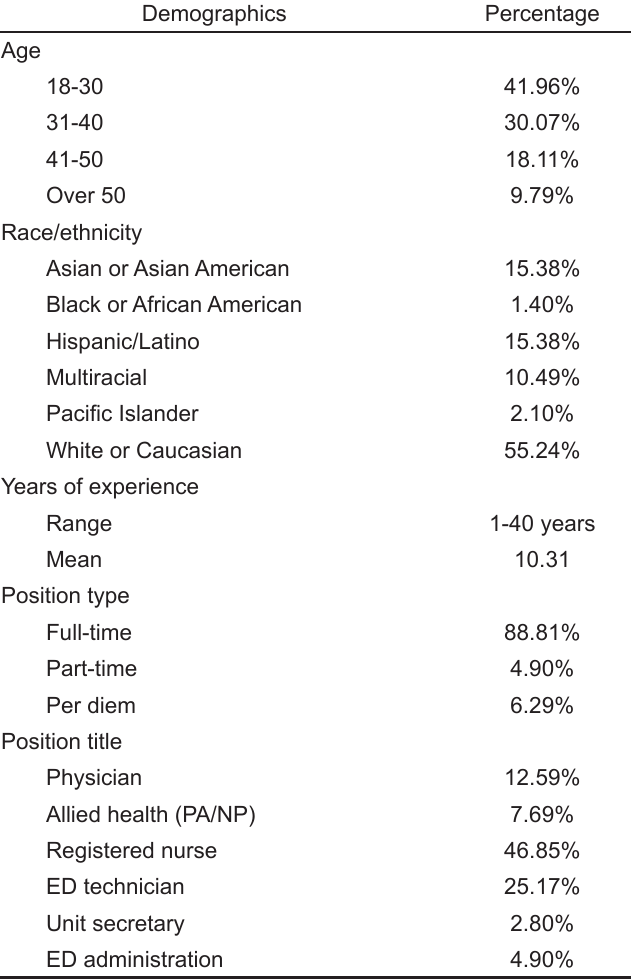
Table 1. Summary table of subject demographics (N =